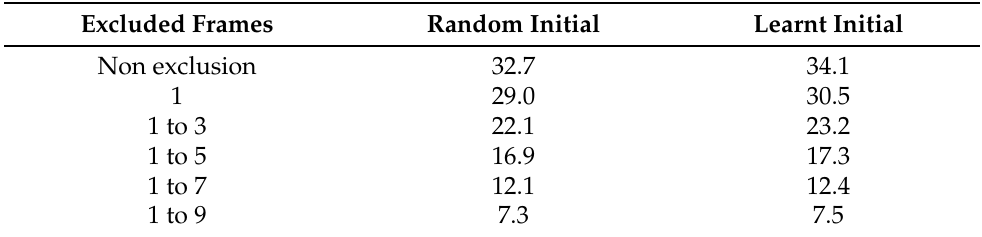
Table 2. Comparison of results with random initial queries and learnt initial queries. We notice that the difference between two initializations vanishes as we exclude more frames at the beginning. Since the valid annotation is not publicly available, we can only evaluate the performance on the dataset official server. That is the main reason for the AP decrease.